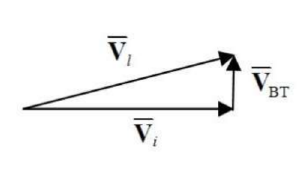
Figure 2. A phasor diagram for the quadrature booster.